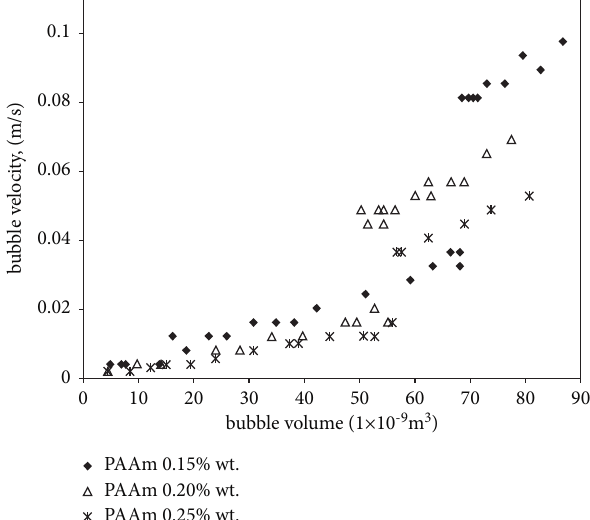
Figure 10: The rising bubble velocity as a function of the bubble volume for three different PAAm concentrations [57].